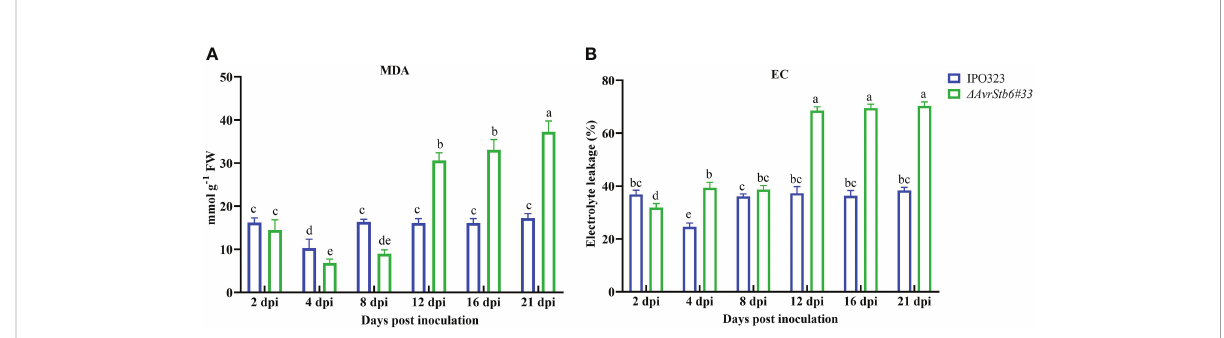
FIGURE 9 AvrStb6-Stb6 interaction impacts the (A) malondialdehyde (MDA) content, and (B) electrolyte leakage (EC) parameter measured in cv. Sha fi r infected by WT IPO323 or D avrStb6#33 strains. Data are indicate as mean ± SD (Standard Deviation) of four biological samples from one independent experiment. Different lowercase letters indicate statistically signi fi cant differences (P ≤